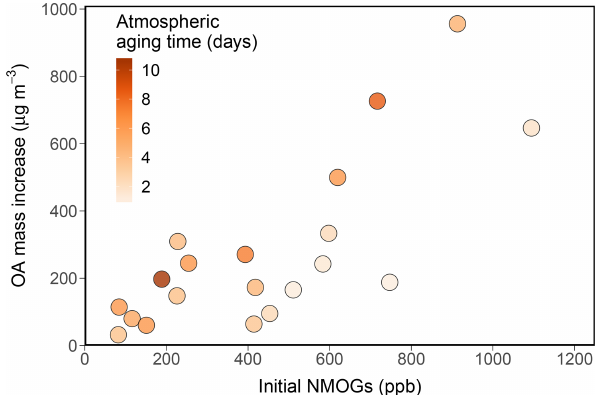
Figure 2. End-of-experiment SOA formation vs. total NMOG con- centration in the chamber prior to OH oxidation. Points are colored by the atmospheric equivalent aging time corresponding to the end of each